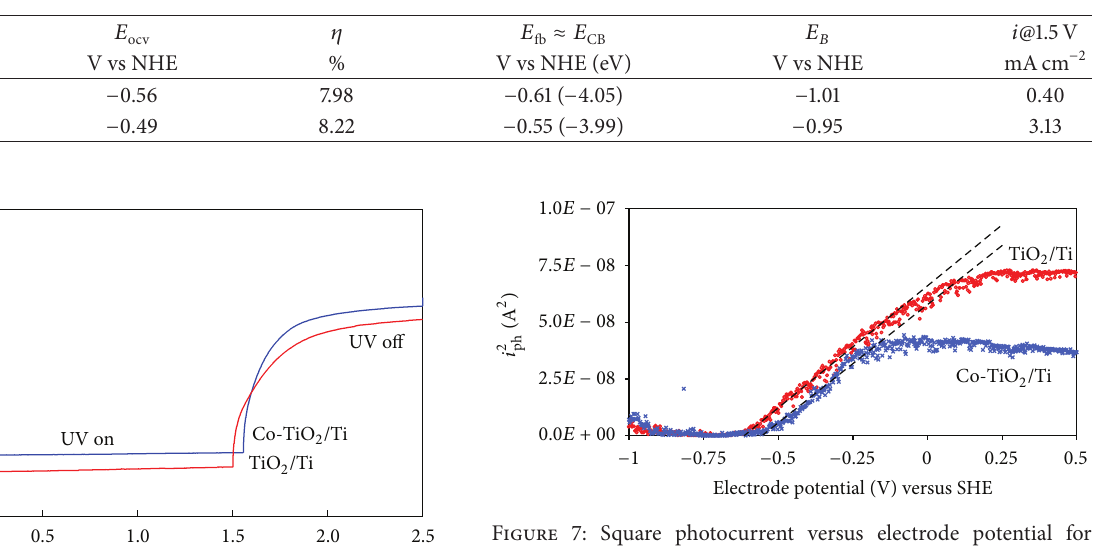
The corresponding dark current for Co-TiO 2 /Ti is also represented for comparison.